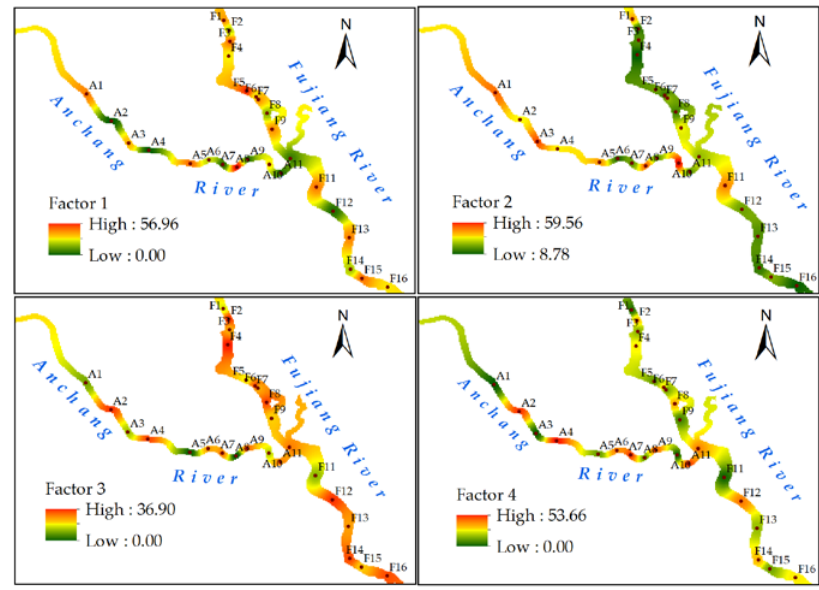
Figure 4. Spatial characteristics of source contributions.